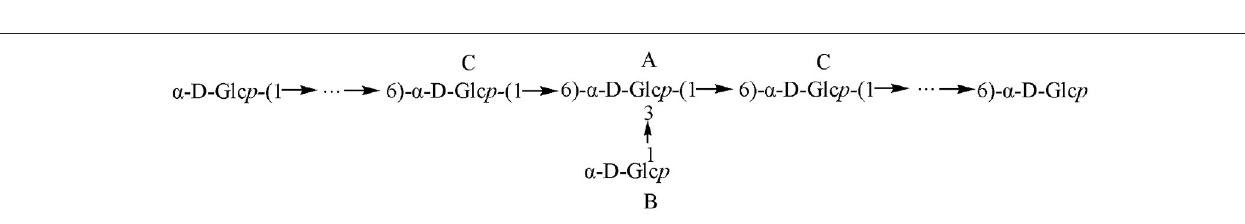
FIGURE 4 | Schematic of the structure of